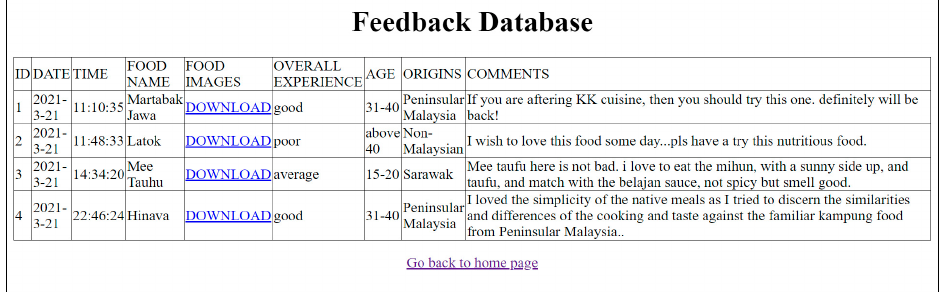
Figure 11. Customer feedback form module.